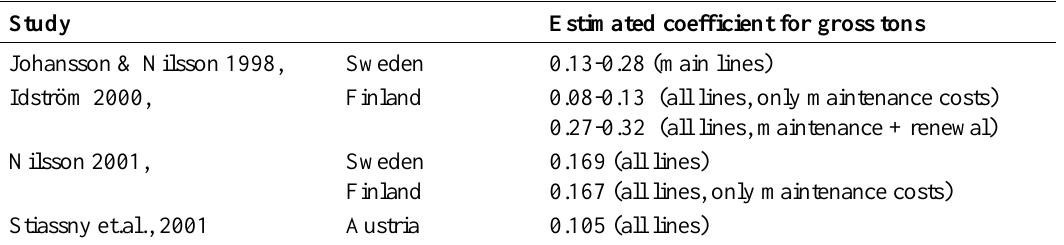
Table 1. Estimation results – coefficients for utilisation (gross tons)